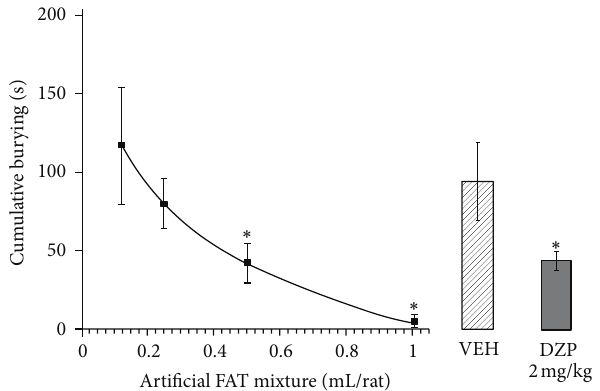
Figure 2: Cumulative burying. Cumulative burying time was significantlyless( ∗ 𝑃 < 0.001 ,SNK posthoc test)inthegroupstreated with 0.5 and 1mL of the artificial FAT mixture and diazepam than in the groups treated with vehicle and the other artificial FAT mixture volumes. The data points of the dose-response curve were fit to a logarithmic curve (𝑅 = 0.9674) . FAT, fatty acid; VEH, vehicle of fatty acid mixture; DZP, diazepam.